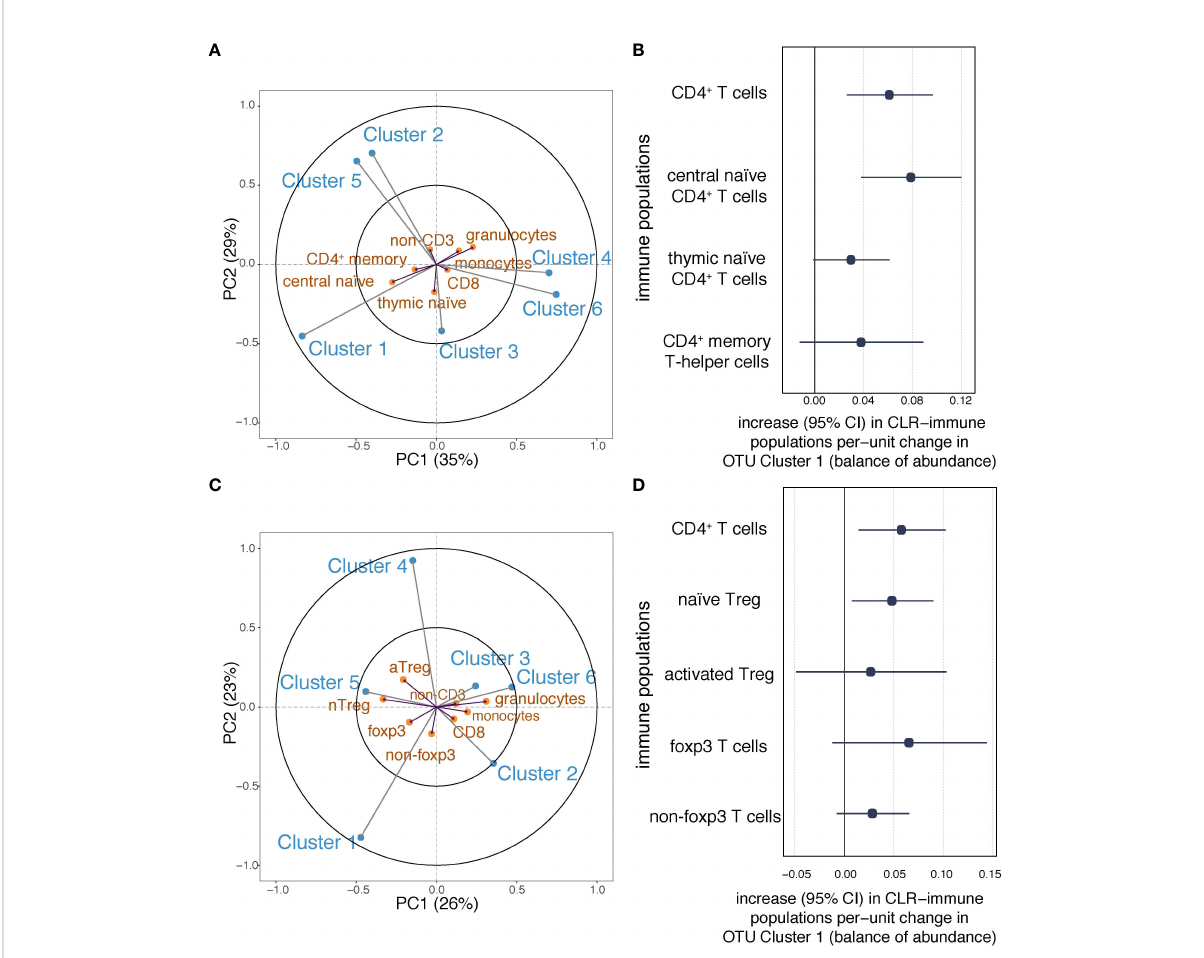
FIGURE 5 Associations between maternal OTU clusters and CD4+ subpopulations at birth. (A) The partial least squares biplot shows the associations between OTU clusters (blue) and immune populations (orange)( n =216). The acute angles between Cluster 1 and central naïve CD4+ T cells suggest a positive association. (B) Increases (with 95% con fi dence intervals) in log-transformed immune populations (CD4+ T cells, and naïve and memory CD4+ T cells) per unit change in automated balances for Cluster 1 abundance. (C) The partial least squares biplot shows the associations between OTU clusters (blue) and immune populations (orange), The acute angle between arrows to Cluster 1 and naïve Tregs indicates a positive association ( n =107). (D) Increases (with 95% con fi dence intervals) in log-transformed immune populations (CD4+ T cells, Tregs, and Foxp3 T cells) per unit change in automated balances for Cluster 1